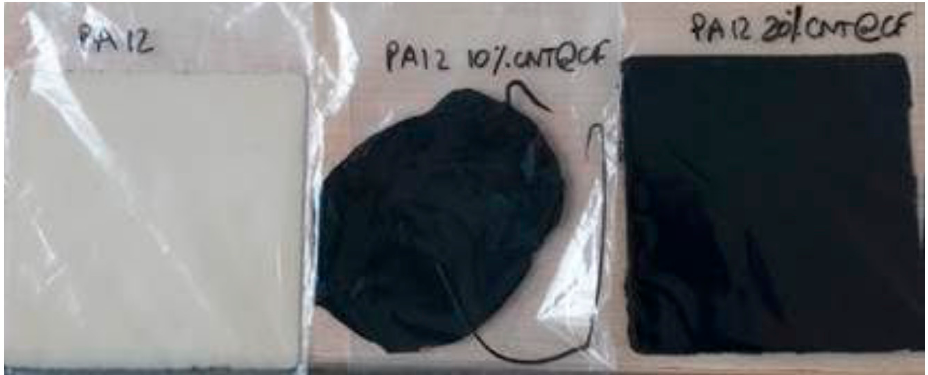
Figure 5. CNTs on chopped CFs (floating catalyst approach: catalyst: ferrocene; carbon source: eth- anol).